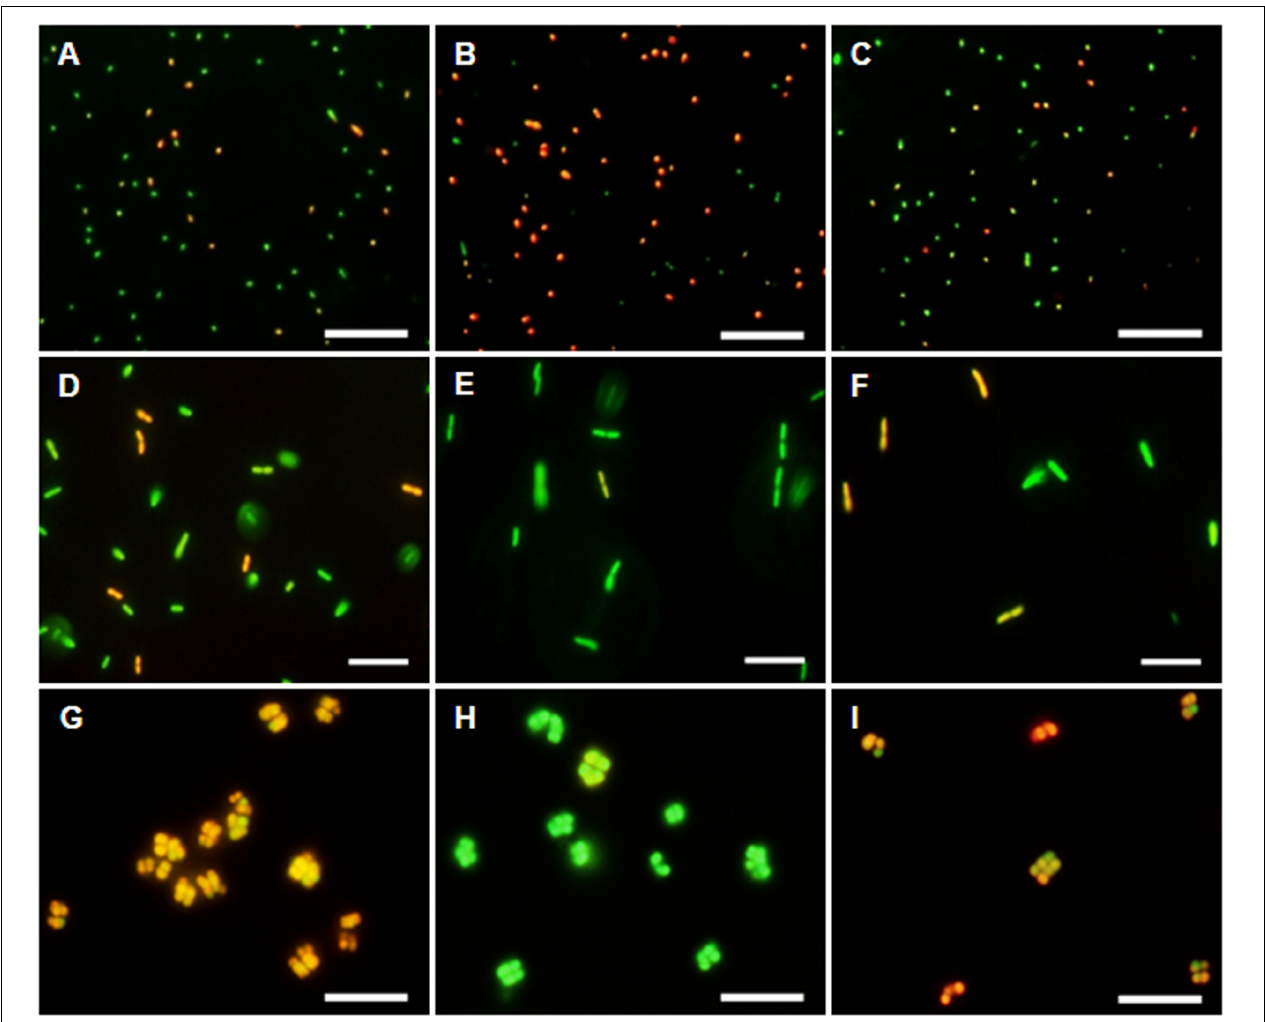
FIGURE 2 | DiOC 2 (3)-uptake at different energetic states. (Left column) Untreated cells in exponential growth phase. (Middle column) Cells after 2 h of N 2 -gassing. (Right column) Cells after 2 h N 2 -gassing, aerated for 2 min subsequently. (A–C) Dye uptake of D. shibae increases after N 2 -gassing but declines after subsequent aeration. (D–F) Dye uptake of E. coli decreases after N 2 -gassing, but increases after subsequent aeration. (G–I) Dye uptake of M. luteus was strongest at the start, decreased drastically after N 2 -gassing, but increases after subsequent aeration. All scales: 10 µ m.